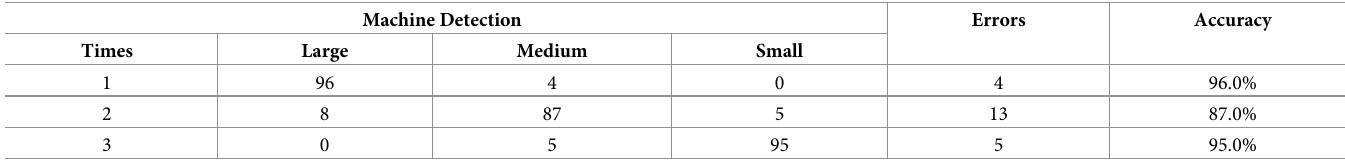
Table 4. Grading results of tomato size